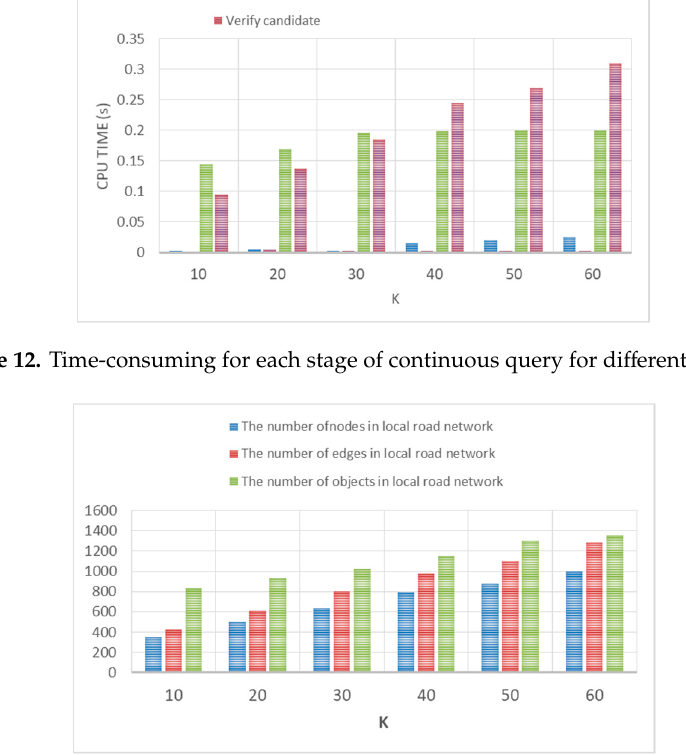
Figure 12. The number of nodes, edges, and moving objects in local road network with different K Figure 9. Comparisons of time consumed with the number of moving objects in different time Figure 13. The number of nodes, edges, and moving objects in local road network with di ff erent values. intervals. K values.